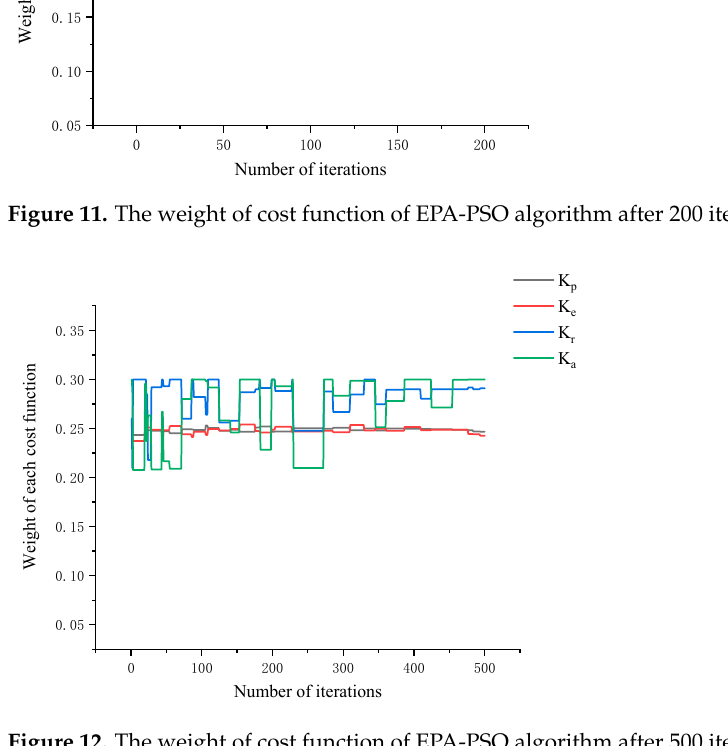
Figure 12. The weight of cost function of EPA-PSO algorithm after 500 iterations.